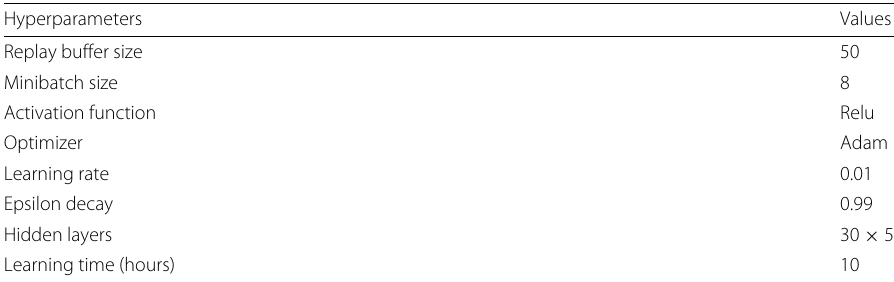
Table 3 Hyperparameters for